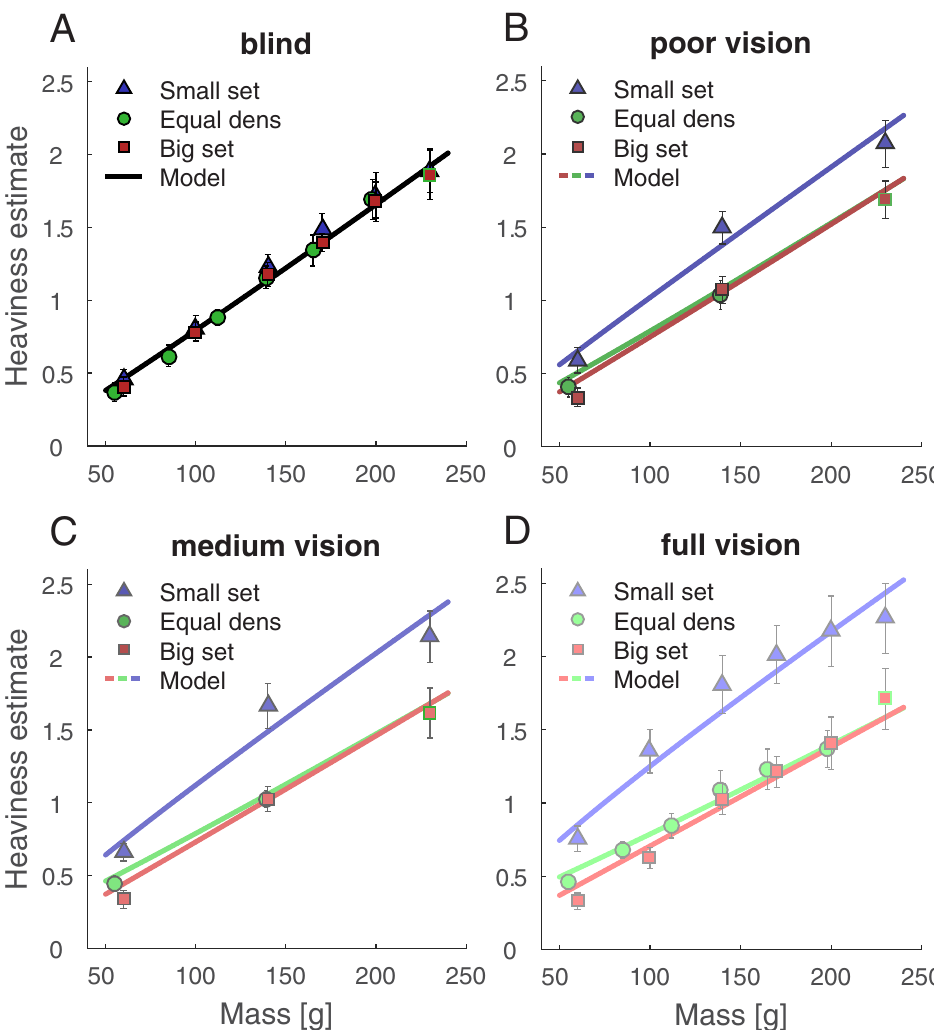
Fig 2. Main results of Experiment 1. Heaviness estimates and model fits for the blindfolded (A), the poor (B), the medium (C) and the full vision condition (D). Estimates are averaged over individual heaviness scores with error bars denoting 95% confidence intervals. Lines represent the model